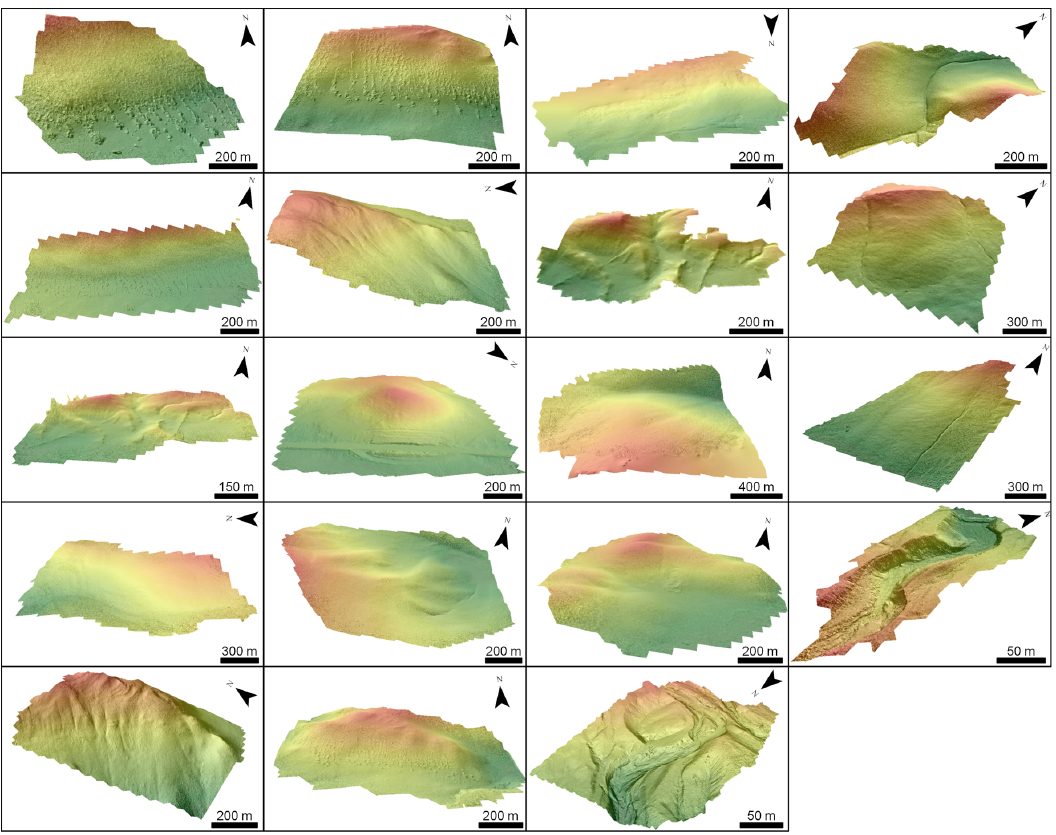
Figure 2. Perspective view of the covered relief of the 19 unmanned aerial vehicle (UAV) digital elevation models. Depicted relative altitudes of the raster datasets are from low (green) to high (red). Flights at all sites were manually conducted between 10 am and 12 am local time on cloud-free days in a line-based pattern at two different heights, flying slower than 2.5 ms -1 to improve the accuracy of planimetry and altitude. Missions result in a high overlap of > 9 images per point.